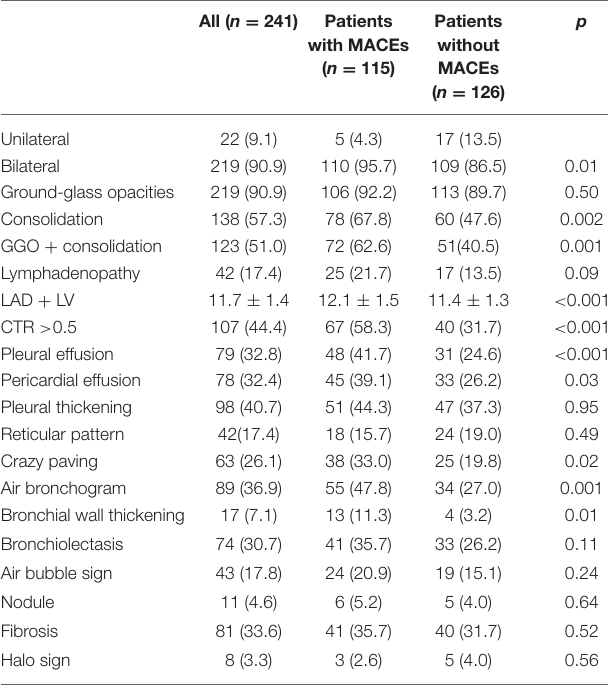
TABLE 2 | Chest CT findings of 241 patients with COVID-19 on